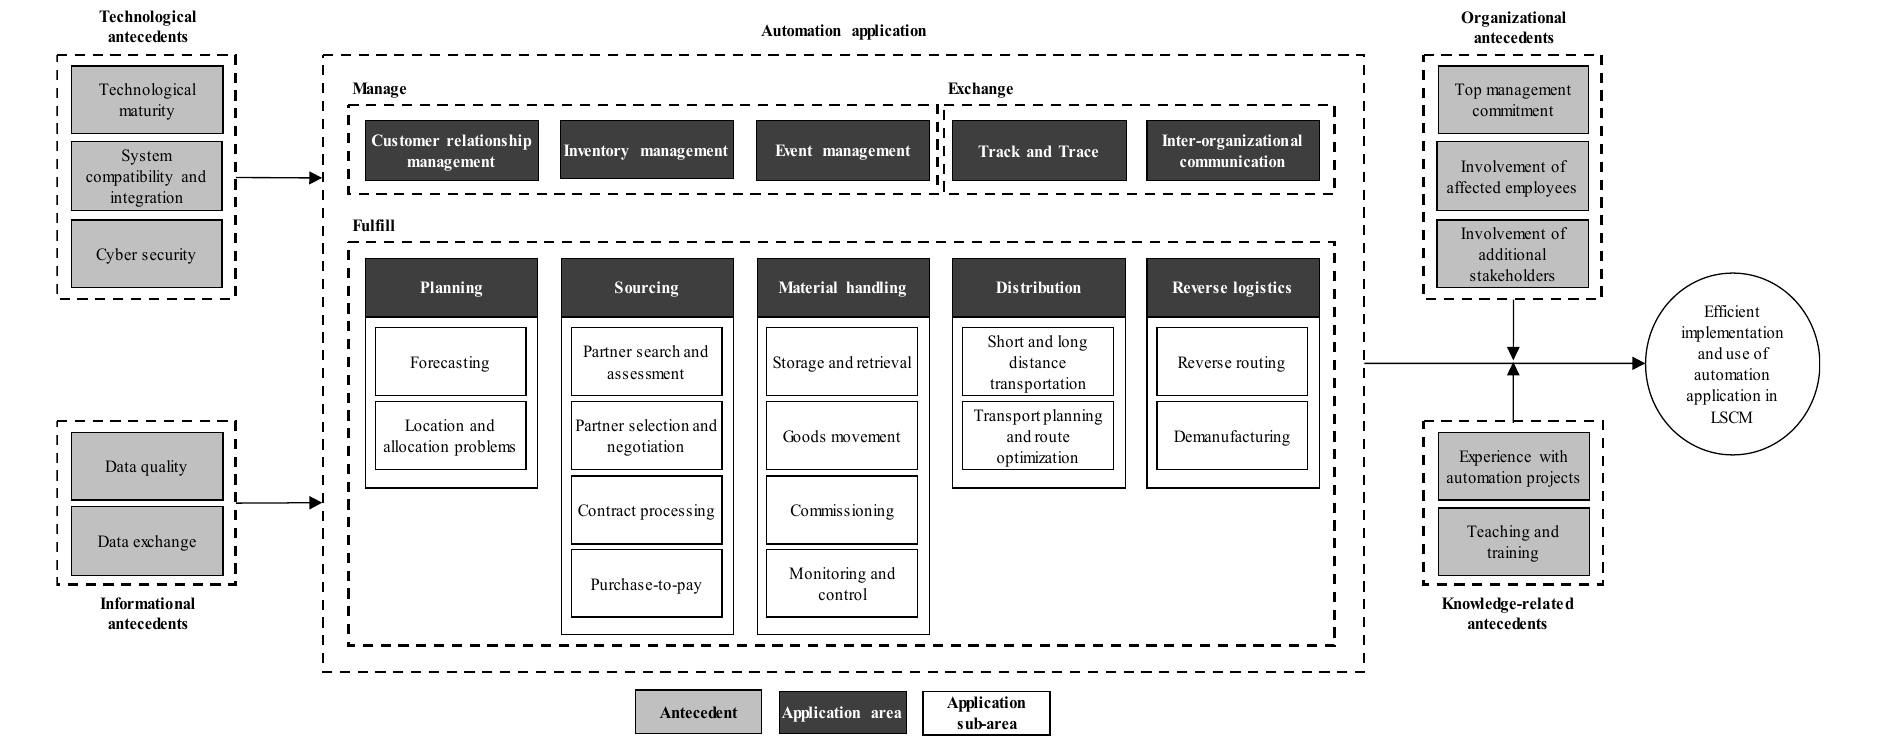
Figure 1. Conceptual framework of automation in logistics and supply chain management [4].